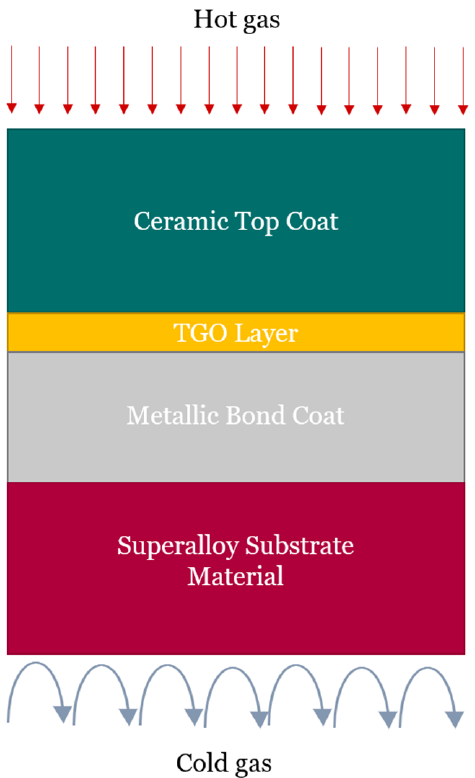
Figure 2. Schematic illustration of a traditional TBC system (not to scale).